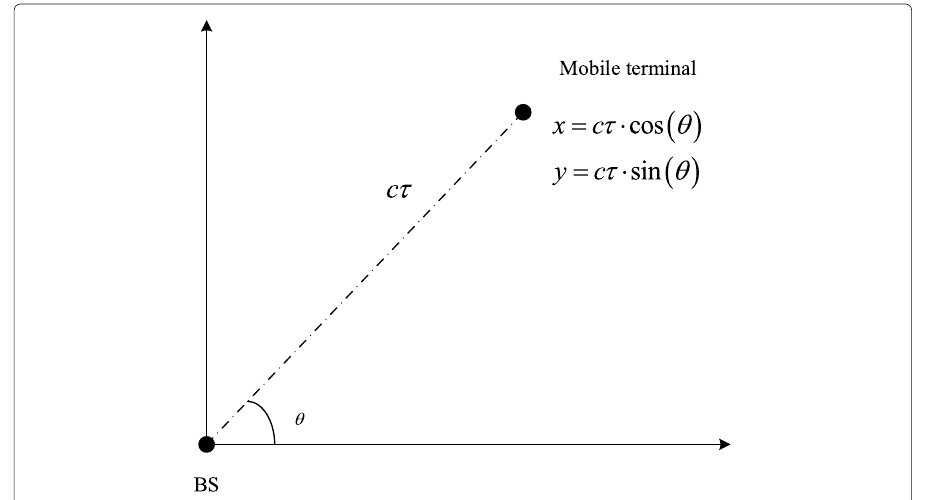
Fig. 1 Traditional single station positioning